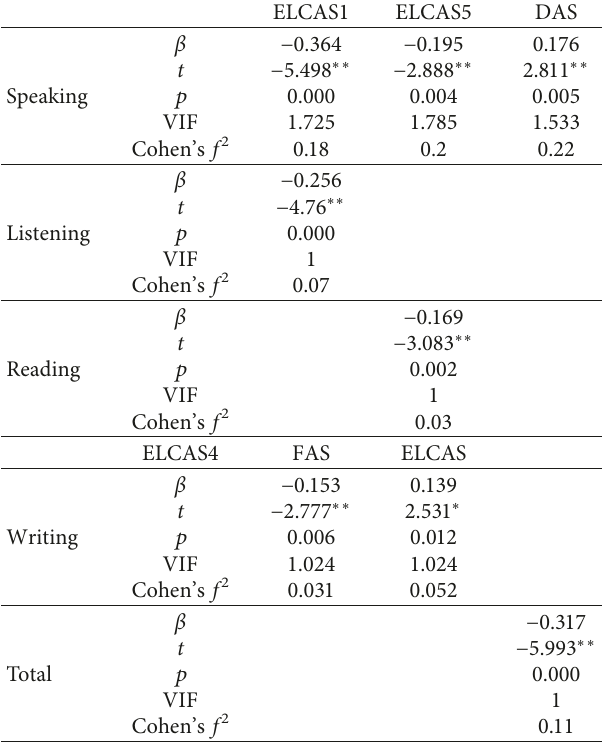
Table 8: Multiple regression coefficients and significance of Pre- dictors for Performance in English (phase